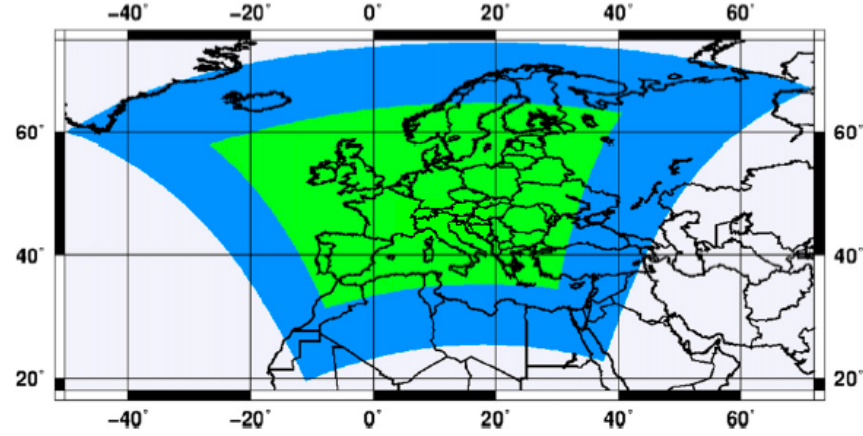
Figure 1. The EURO-CORDEX domain (blue) and the internal domain (green) used for the high-resolution integration. Adapted from